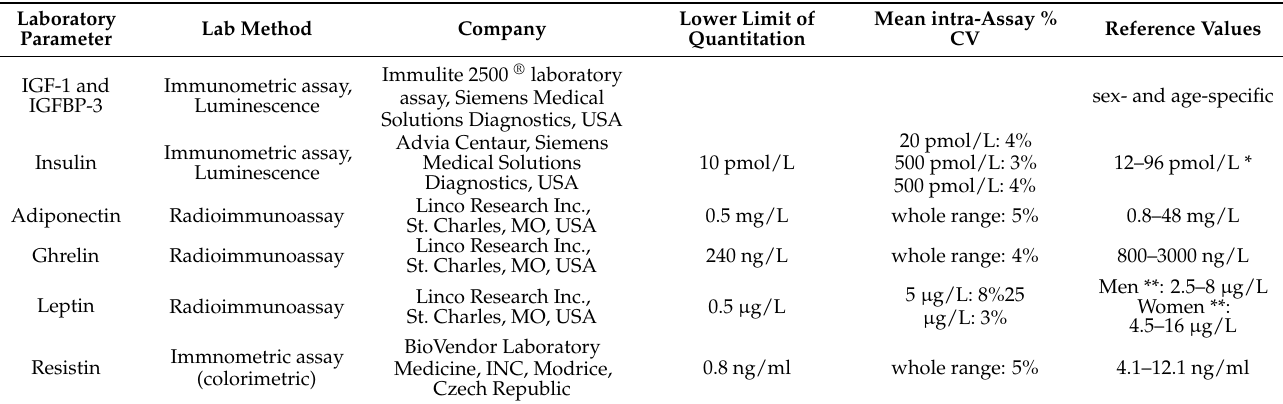
Table A1. Hormonal